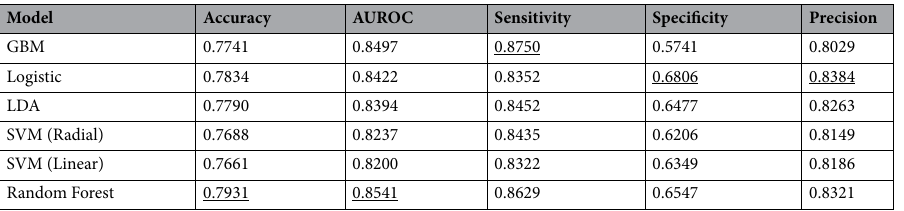
Table 2. The model prediction performance measured by five measurements. Each measurement was calculated under ten-fold cross-validation and then averaged across ten repetitions. The highest values among the six models are